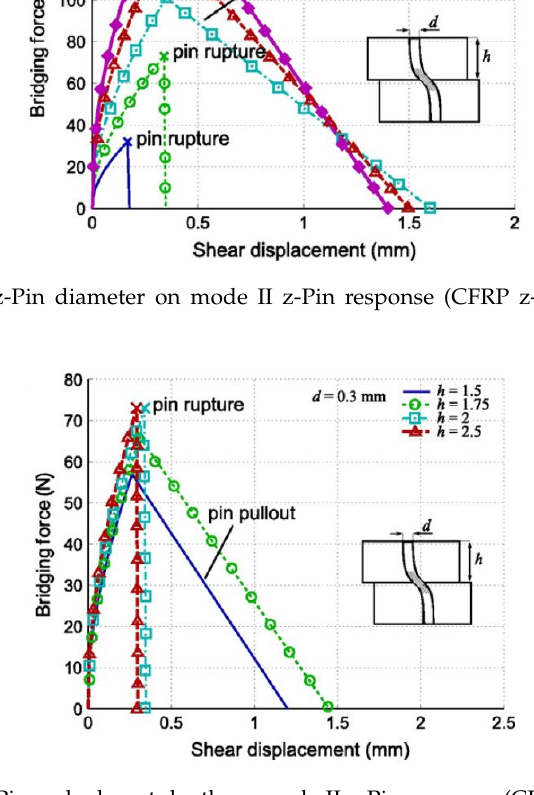
Figure 19. E ff ect of z-Pin embedment depth on mode II z-Pin response (CFRP z-Pins, d = 0.3 mm, F igure 19. Effect of z-Pin embedment [0] pre-preg) depth on mode II z-Pin response (CFRP z- Pins, d = 0.3mm, [0] pre-preg) [23].